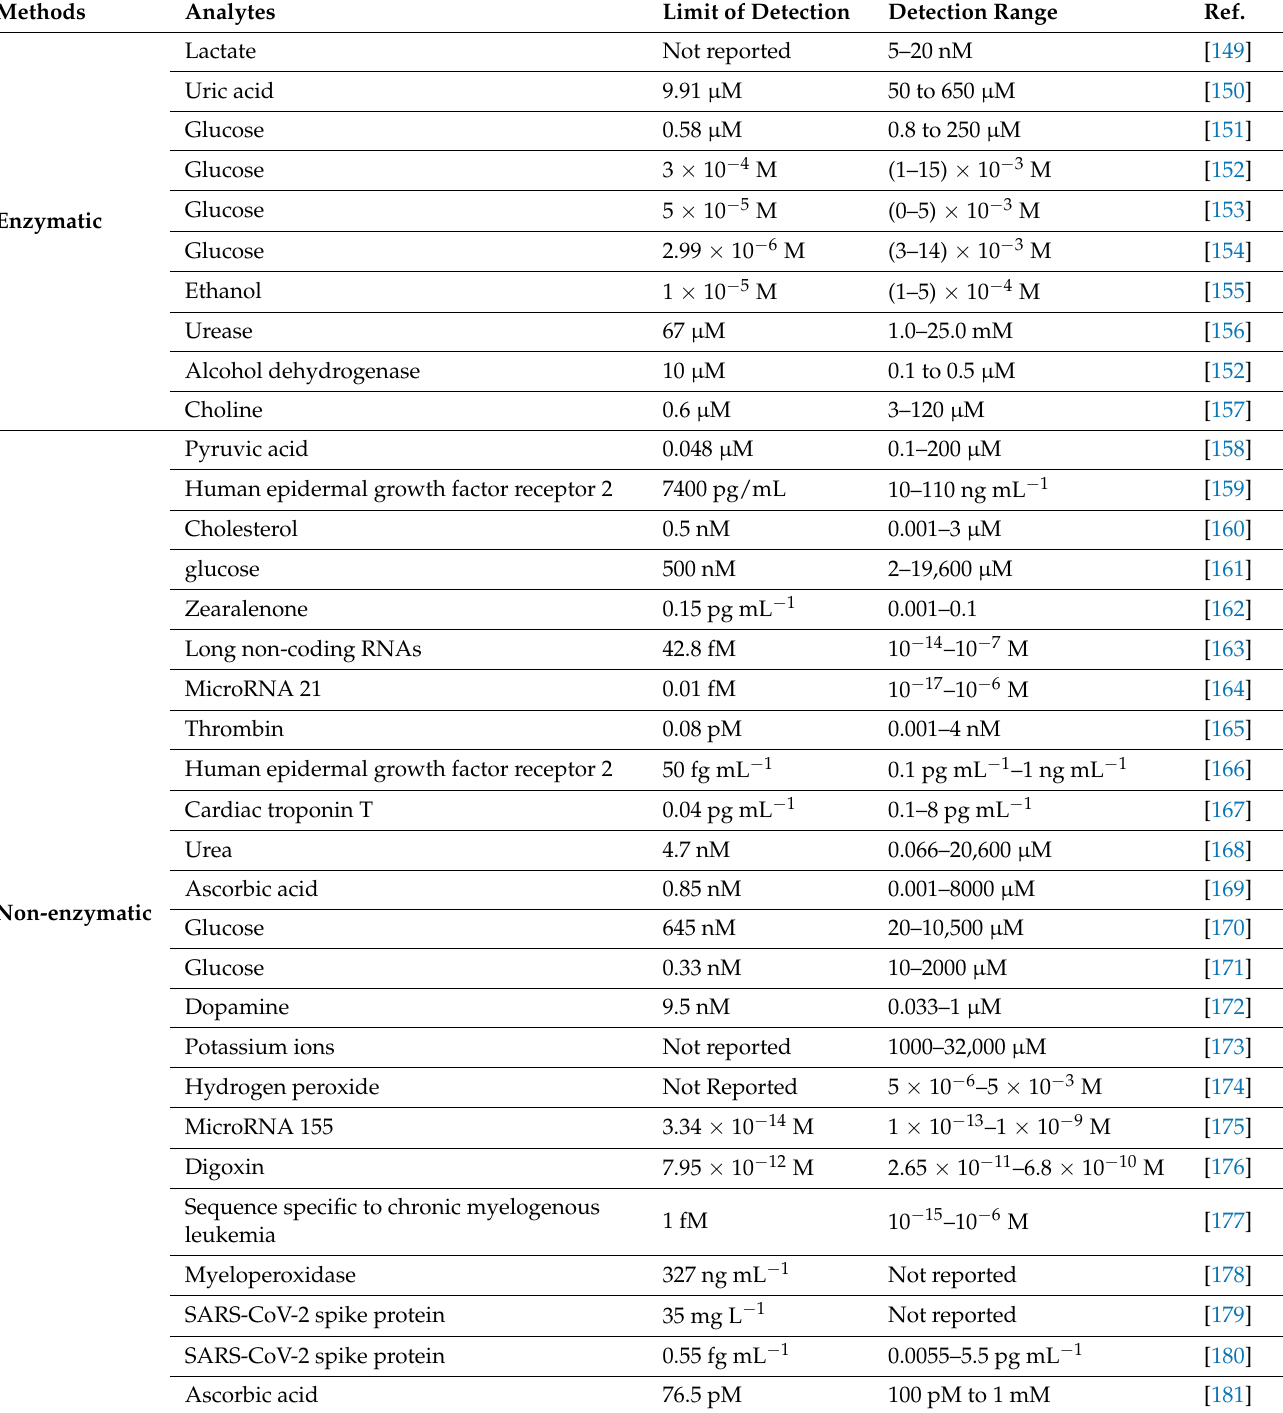
Table 2. Summarization of CNT-based enzymatic and non-enzymatic